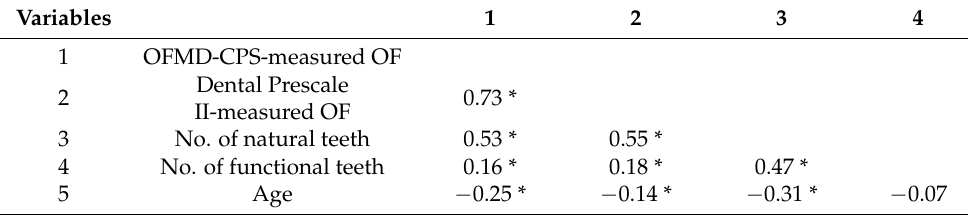
Table 4. Correlation between OF, the numbers of natural teeth and functional teeth, and age.